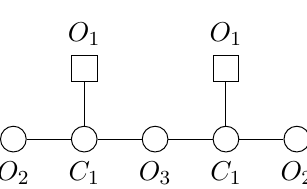
Figure 64. Quiver obtained from brane systems in the (cid:12)rst row of table 6. Its Higgs branch is M H = D 4 .